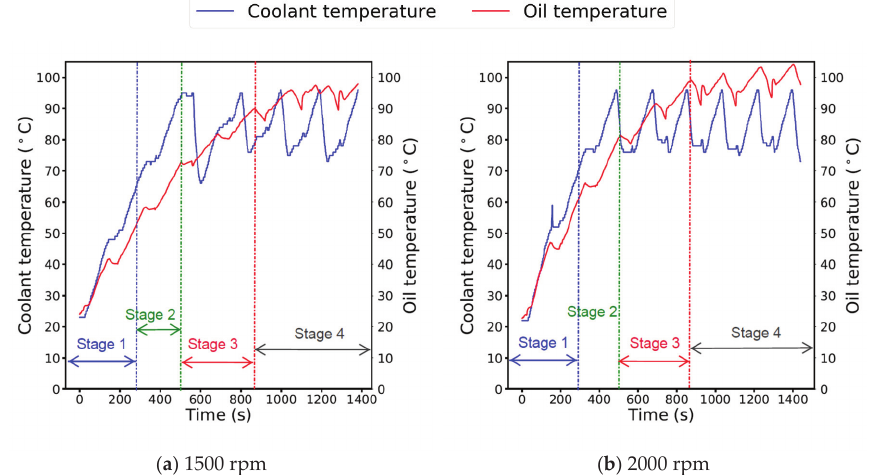
Figure 3. Coolant and oil temperatures during the custom drive cycle tests at ( a ) 1500 and ( b ) 2000 rpm. The blue line corresponds to the coolant temperature and the red line corresponds to the oil temperature.